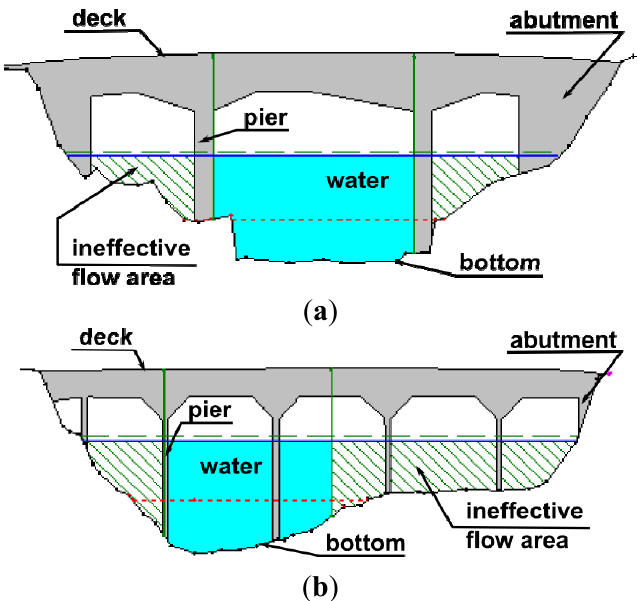
Figure 5. HEC-RAS representation of modeled bridges located in Wronki: ( a )